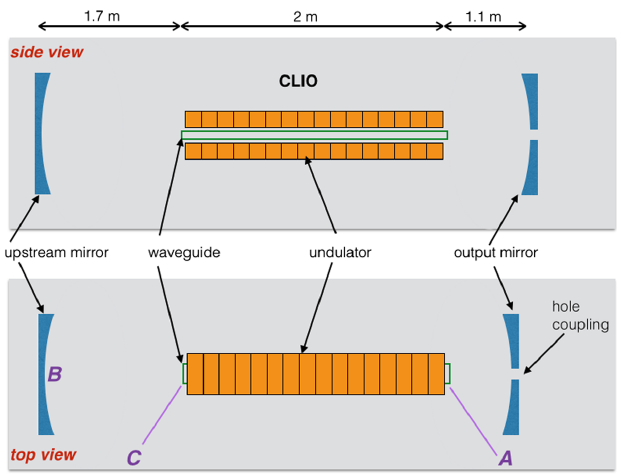
FIG. 9. Layout of CLIO Free-Electron